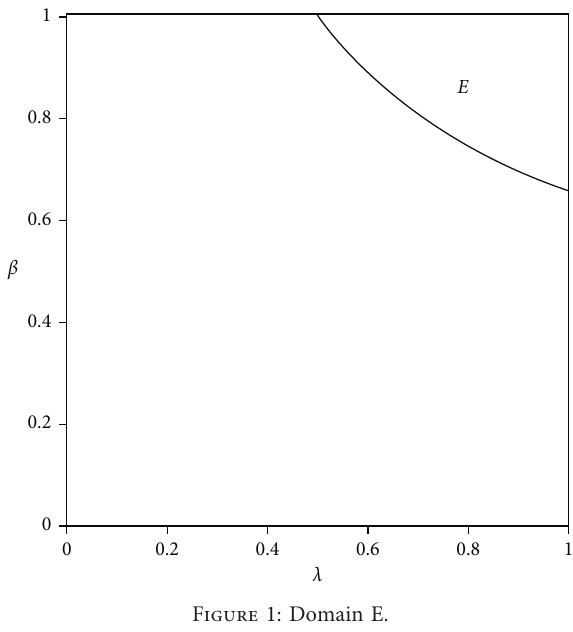
Figure 1: Domain